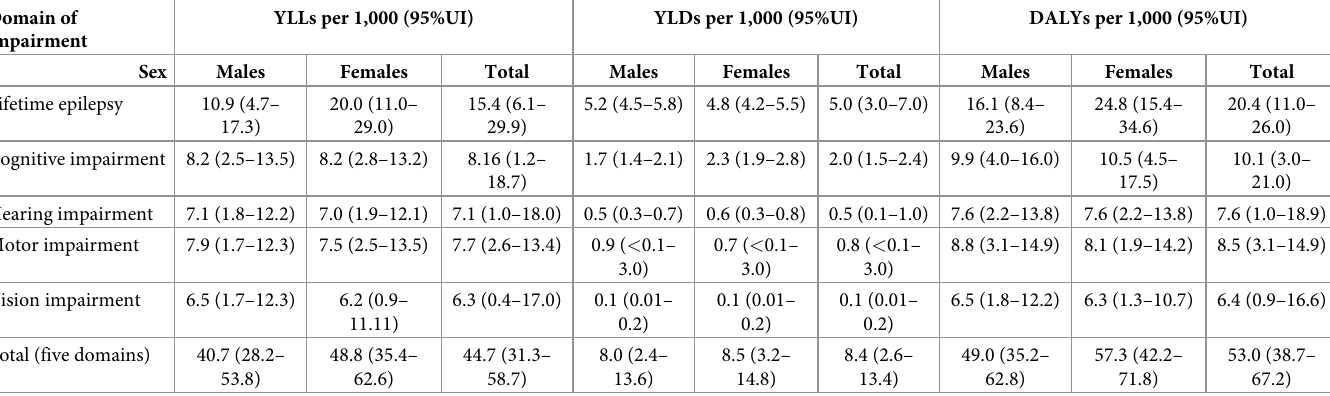
Table 3. Relative estimates of YLL, YLDs, and DALYs per 1,000 (95% uncertainty intervals) classified by sex and NI domain for children aged 5–14 years in Kilifi, Kenya. Domain of